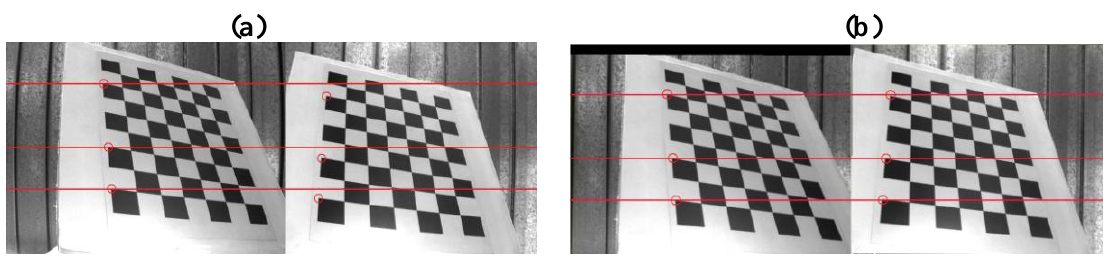
Figure 8. Image rectification result. A stereo pair: (a) before being rectified (b) after epipolar rectification.